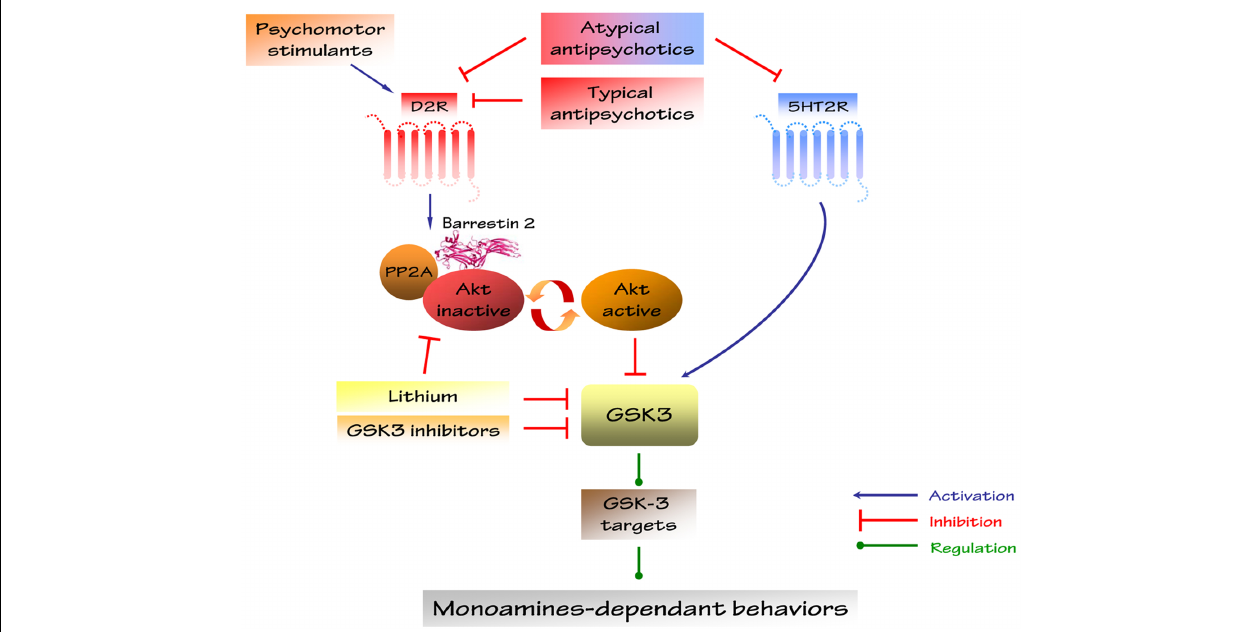
FIGURE 4 | Regulation ofAkt/GSK3 signaling by drugs affecting dopamine and 5-HT neurotransmitter systems. Monoamines-dependent behaviors have been discovered in Akt1- and β Arr2-KO mice and in GSK3 β heterozygous mice.